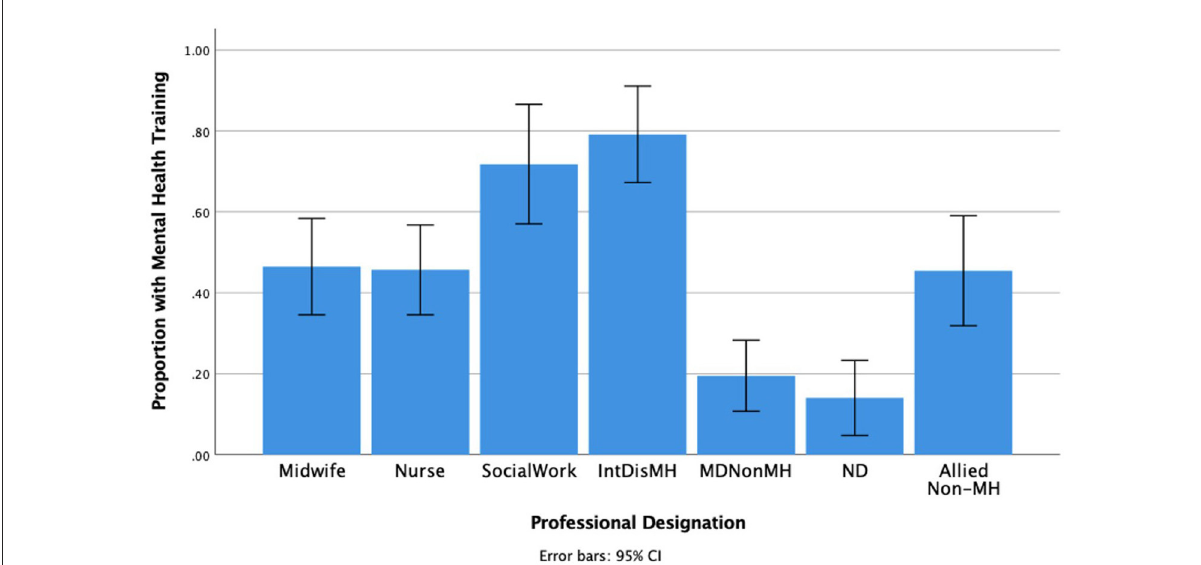
FIGURE1 Perinatal Mental Health Specific Training by Profession. IntDisMH includes psychiatrists, psychologists, psychotherapists, and counselors and this is the group that we would expect would most likely screen for and treat PMHDs. MDNonM H, Obstetrician-gynecologists, family doctors, pediatricians, other physicians; ND , Naturopathic doctors; Allied Non-MH , Allied non-mental health professionals.